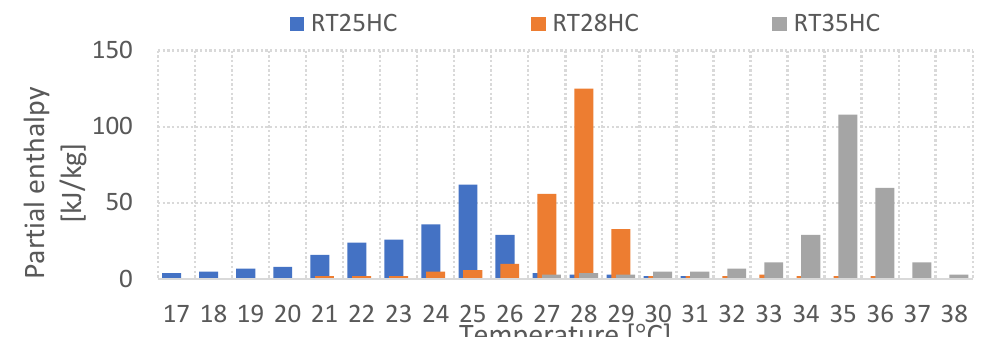
Figure 2. Partial enthalpy of three selected paraffins.